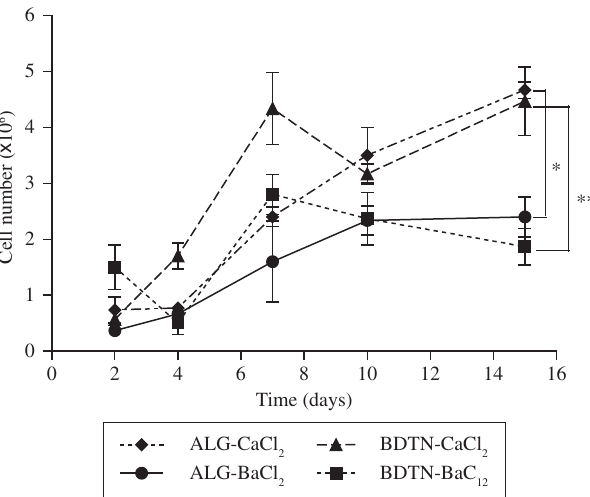
Figure 5. Kinetics of metabolic activity of RINm-5f cells encapsulated in BDTN + BaCl (square), BDTN + CaCl 2 (triangle), *p < 0.05 and **p < 0.01 (One-way ANOVA with ALG + CaCl 2 Tukey post test). BDTN – Biodritin ® , ALG – Alginate.